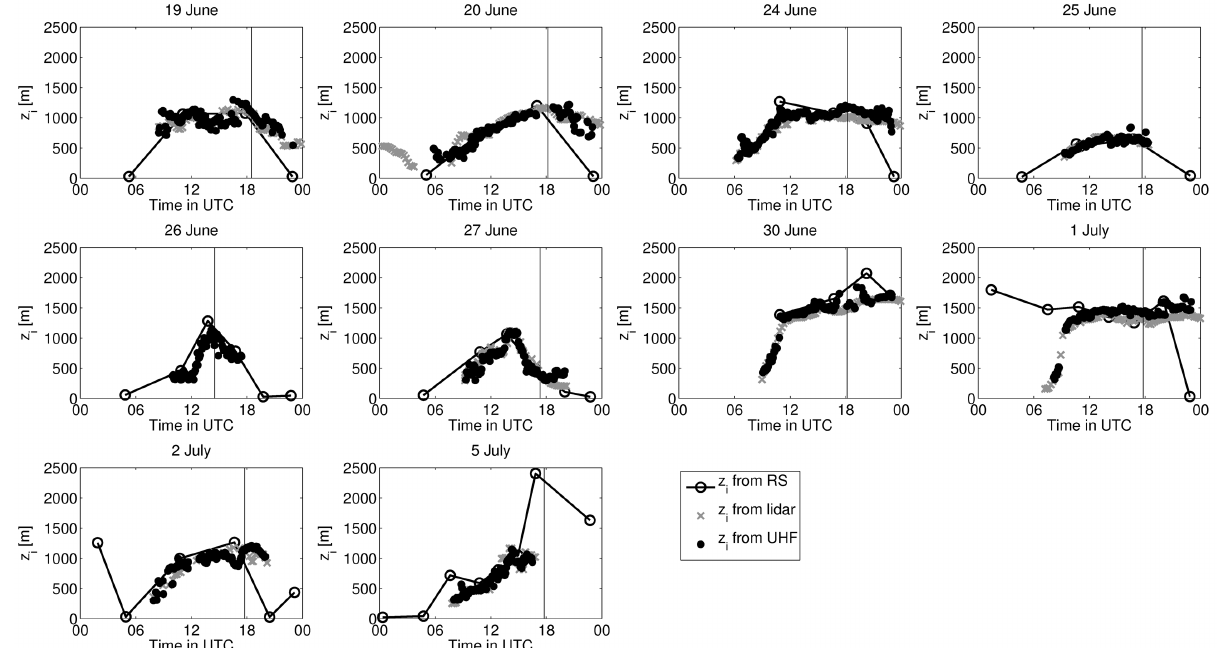
Figure 2. Boundary layer depth ( z i ) estimates from (black dots) UHF wind profilers (based on reflectivity), (grey crosses) aerosol lidar (based on backscatter) and (open circles) radiosoundings (based on the strongest potential temperature gradient). A vertical line has been included to mark the timing of zero-buoyancy flux at